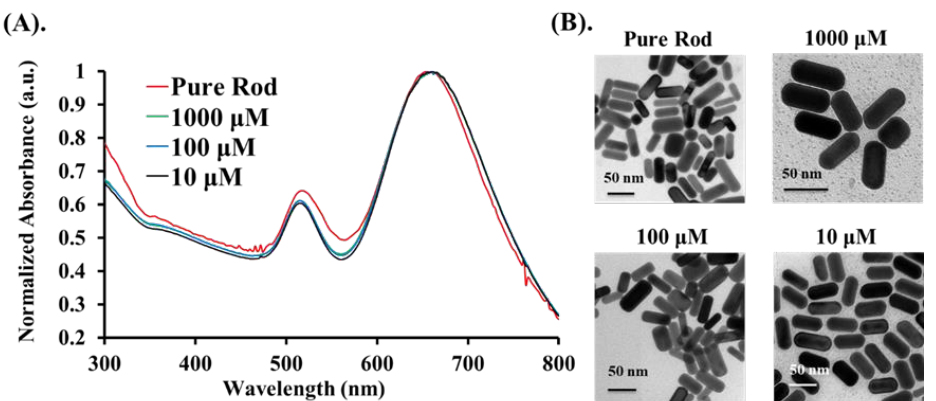
Figure 2. Different concentrations (10 µ M, 100 µ M, and 1000 µ M) of Au@Cys NRs: ( A ) UV–VIS absorption spectrum, and ( B ) TEM images.